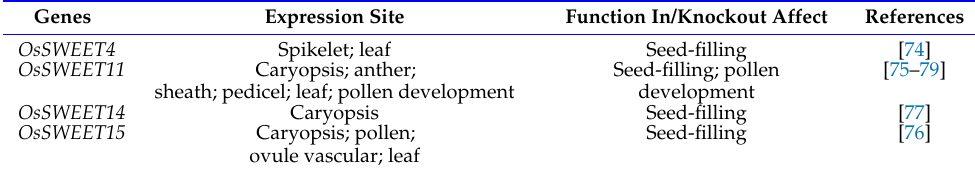
Table 3. Rice SWEET genes and their physiological functions.